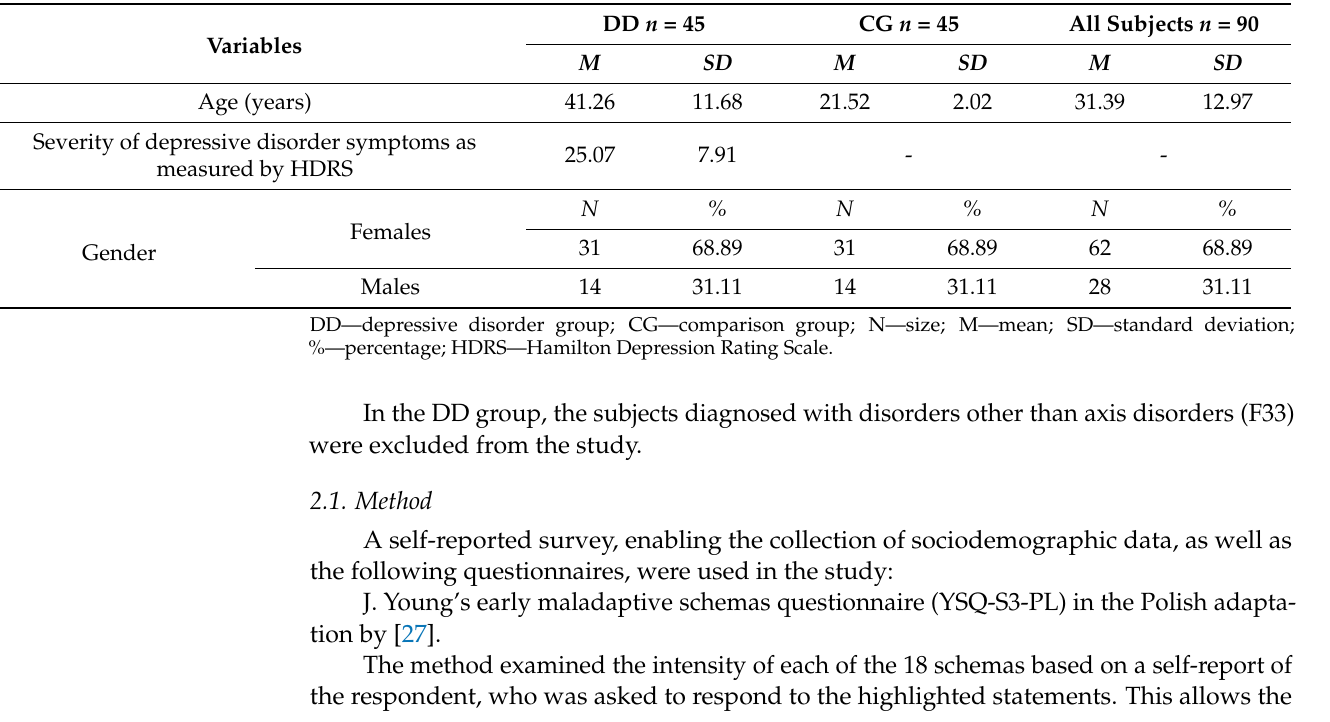
Table 2. The social and demographic characteristics of the study